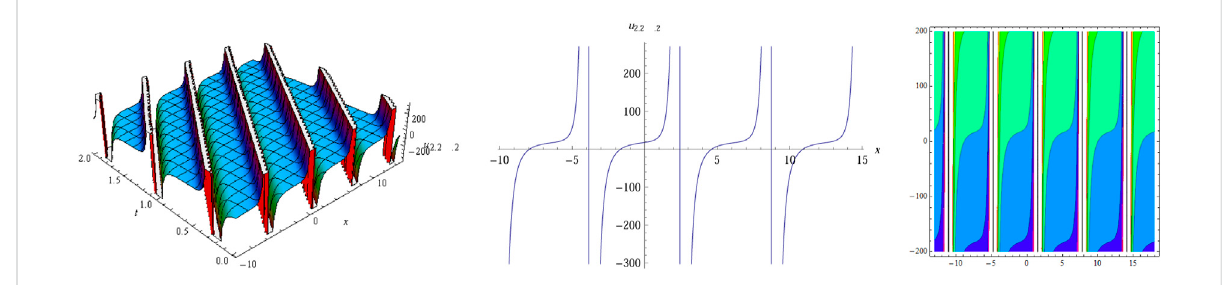
FIGURE 4 3D plot, 2D plot, and contour plot of u 2 . 2 . 2 with α (cid:2) 1 , β (cid:2) 1.